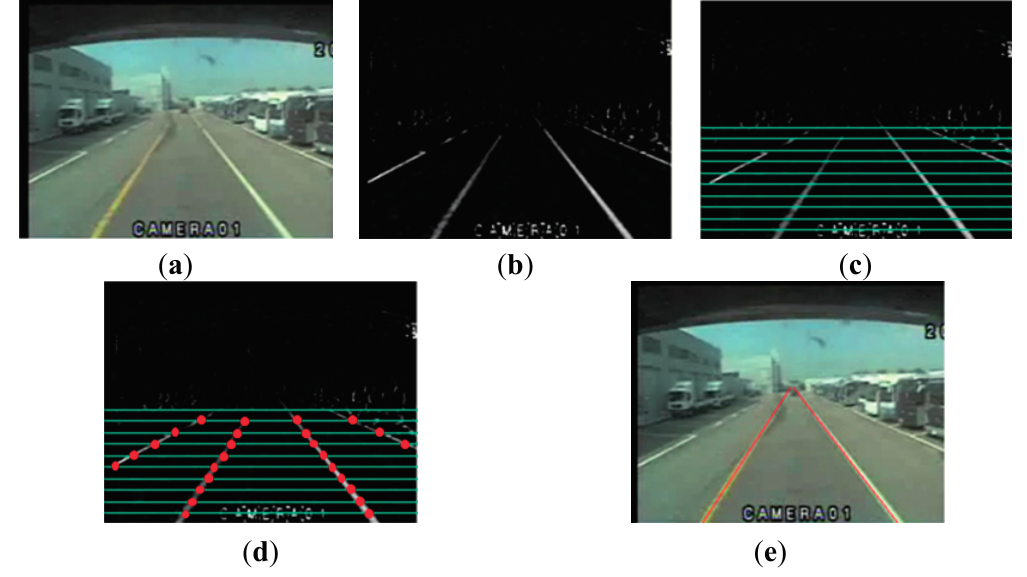
Figure 5. Lane detection: ( a ) input image; ( b ) brightness enhancement and thresholding; ( c ) line scanning; ( d ) selecting candidate points; ( e ) lane